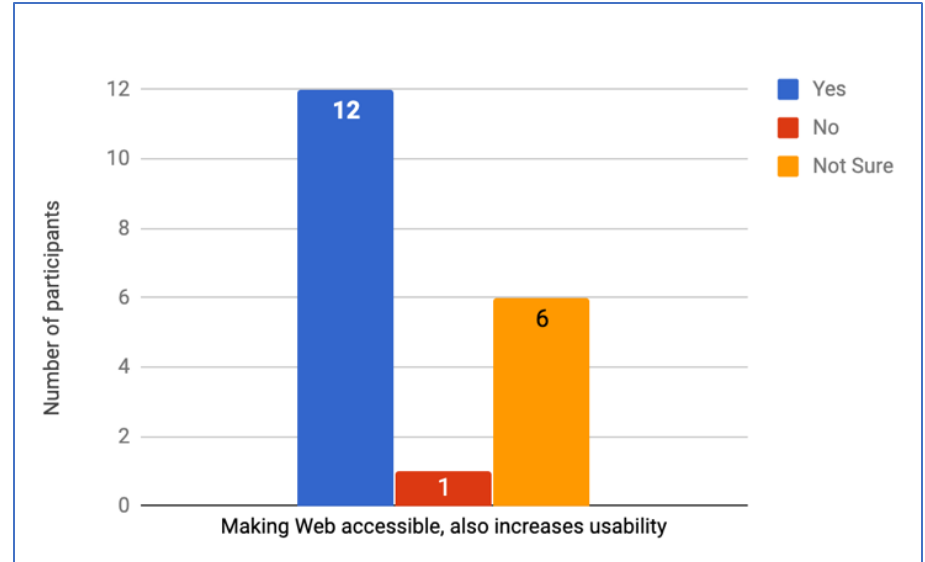
Figure 8. Accessibility contributes to usability.